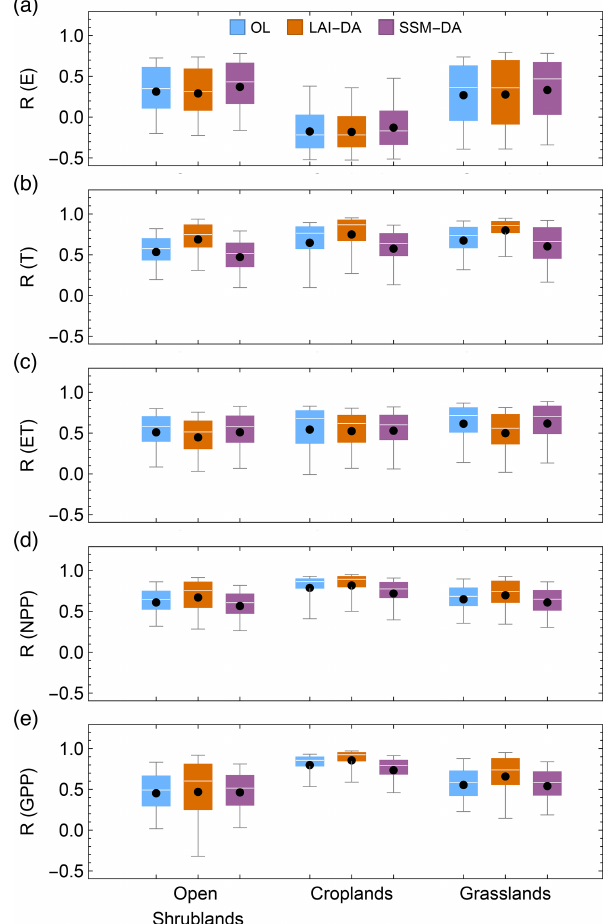
Figure 3. Box plots of the correlation for (a) evaporation ( E ), (b) transpiration ( T ), (c) evapotranspiration (ET), (d) net primary production (NPP), and (e) gross primary production (GPP) strati- fied by the major land cover classifications for the OL, LAI-DA, and SSM-DA simulations for the period of 2015–2019. White lines represent the median, boxes represent the upper and lower quantiles, black whiskers represent the 5th and 95th percentiles, and black dots represent the mean